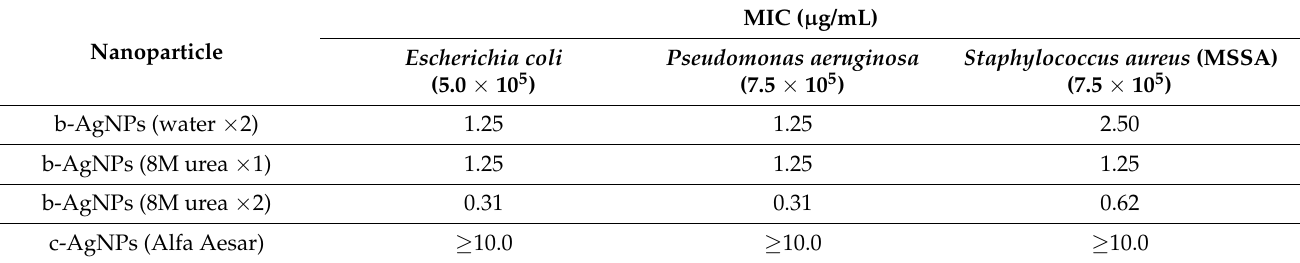
Table 2. Minimum inhibitory concentrations (MIC) of tested nanoparticles against Escherichia coli, Pseudomonas aeruginosa, and Staphylococcus aureus after 24 h incubation at 37 ◦ C in ambient air.